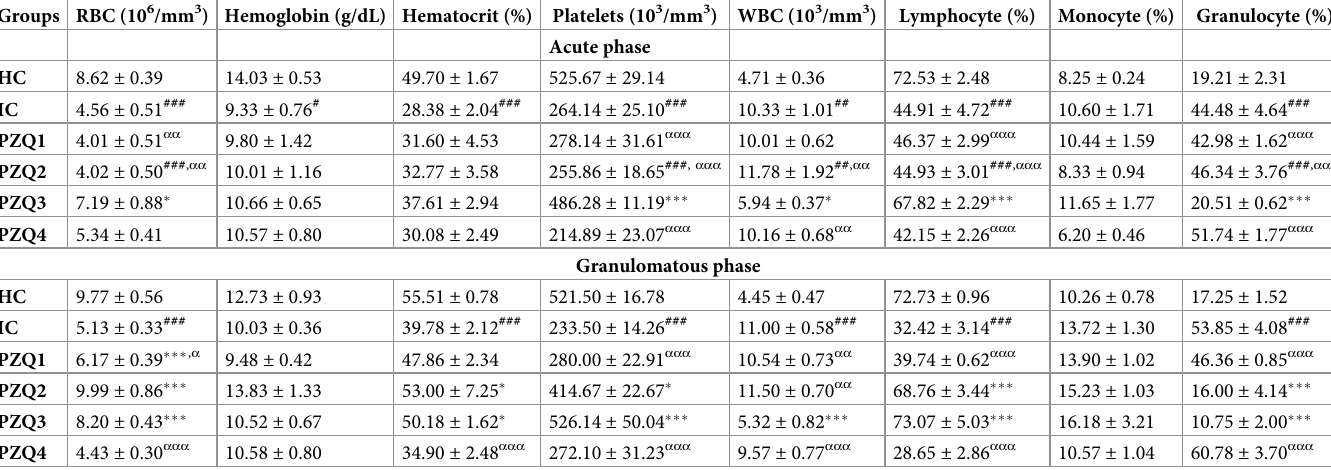
Table 4. Effect of praziquantel treatment on the hematological parameters on Schistosoma mansoni- infected mice. Groups RBC (10 6 /mm 3 ) Hemoglobin (g/dL) Hematocrit (%) Platelets (10 3 /mm 3 ) WBC (10 3 /mm 3 ) Lymphocyte (%) Monocyte (%) Granulocyte